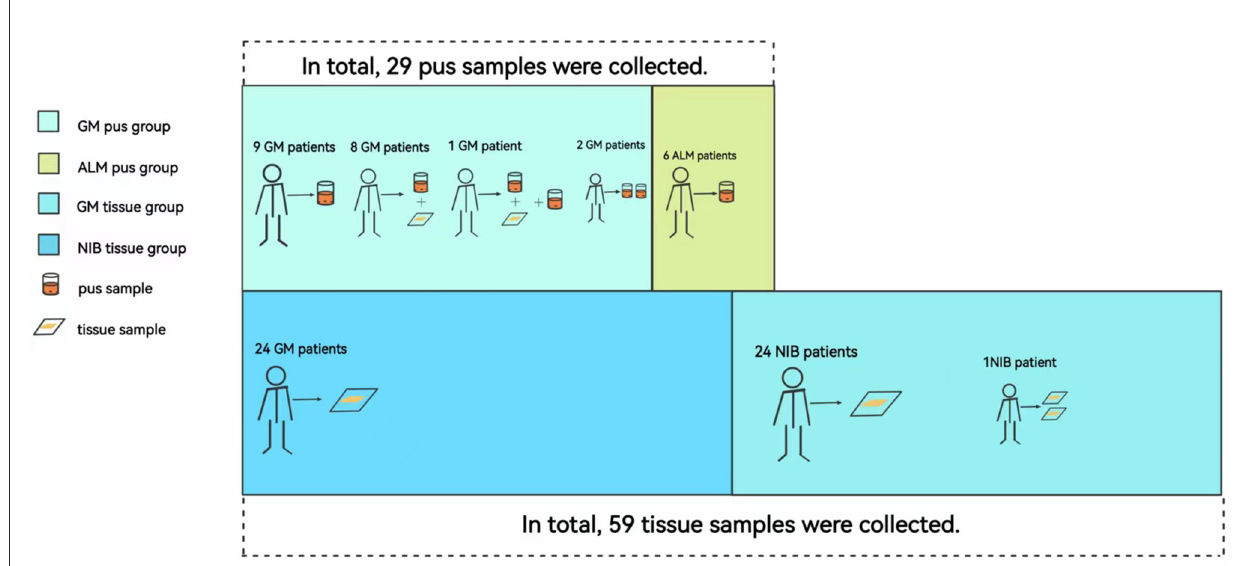
FIGURE2 Correspondence between samples and patients in each group. Abbreviations: ALM, acute lactation mastitis; Ck , Corynebacterium kroppenstedtii ; GM, granulomatous mastitis; NIB, non-inflammation breast disease. Patients had different samples due to their disease condition and the number of follow-up visits. In this figure, we can see that eight patients in the GM pus group had both pus and tissue samples; one patient had two pus samples taken at two different times and one tissue sample. In the NIB tissue group, one patient had two tissue samples collected because she had bilateral fibromas and underwent two surgeries at different